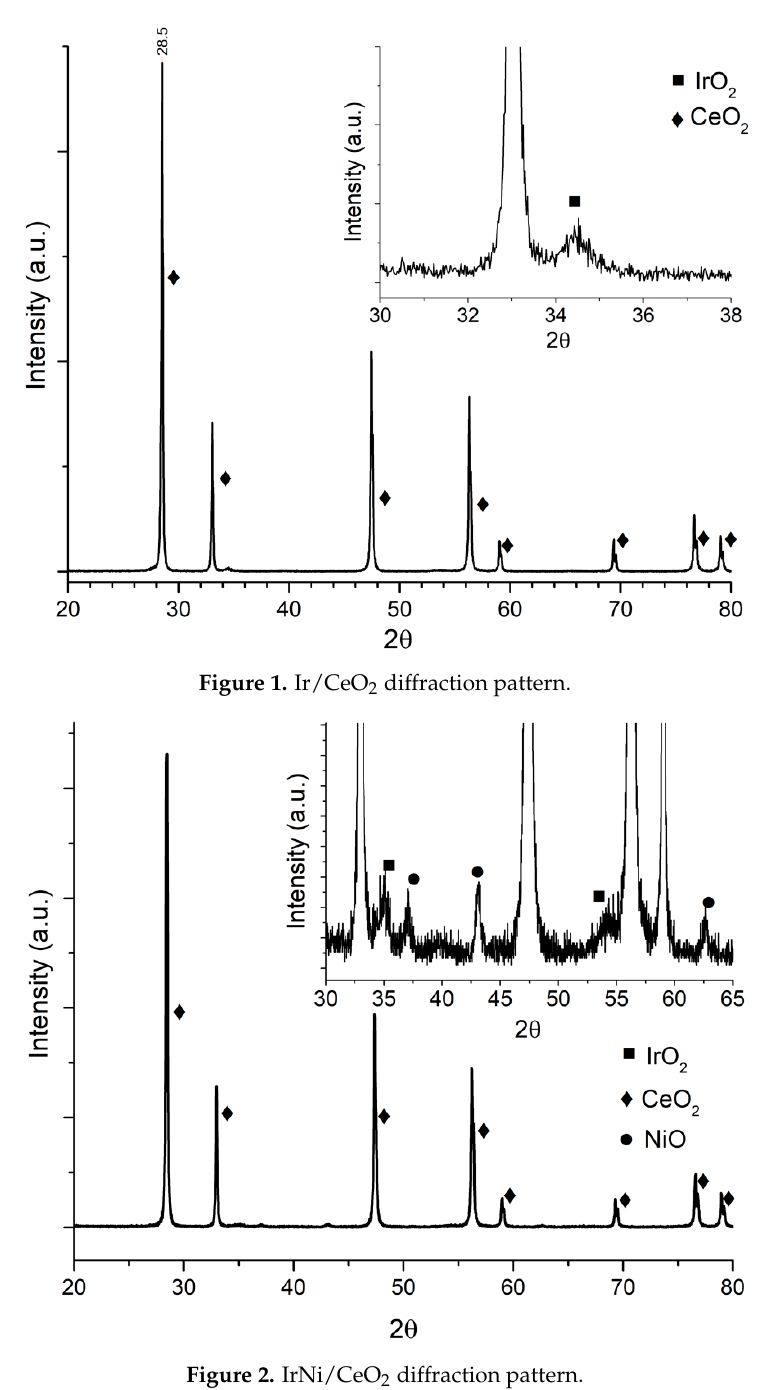
Figure 2. IrNi/CeO 2 diffraction pattern.